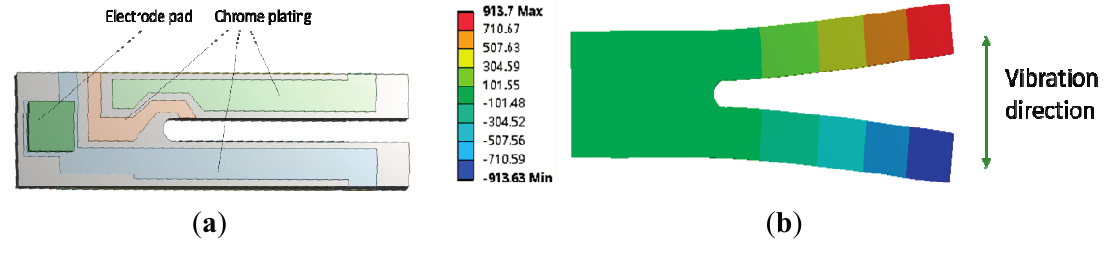
Figure 12. ( a ) The geometry; and ( b ) the fourth mode shape of the TF with FEM